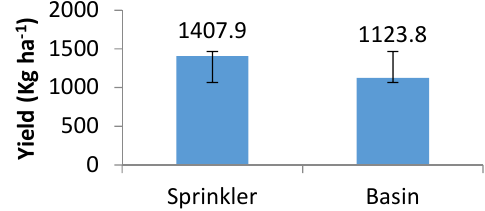
Fig. 3: Yield of crop obtained under T 1 And T 2 treatments